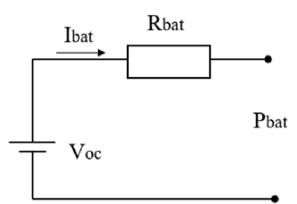
Figure 2. Rint model of a lithium battery.